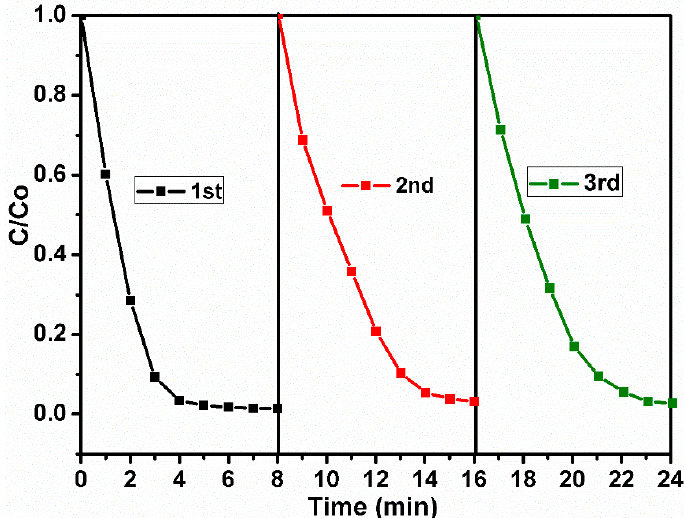
Figure 8. Stability and recycling of the CNT-COO − /Ag 3 PO 4 @AgIO 4 -5% composite.